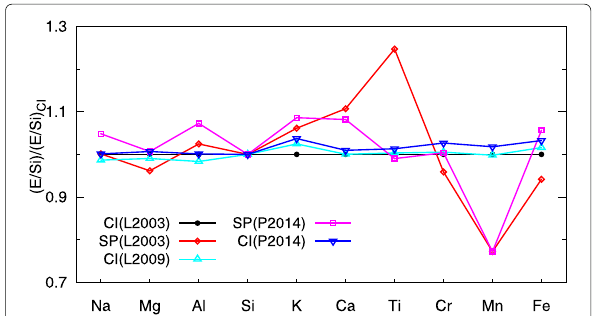
Fig. 4 The elemental abundances from various sources, normalized to the CI elemental abundances of Lodders (2003). CI: CI chondrite. SP: solar photosphere. L2003: Lodders (2003). L2009: Lodders et al. (2009). P2014: Palme et al.